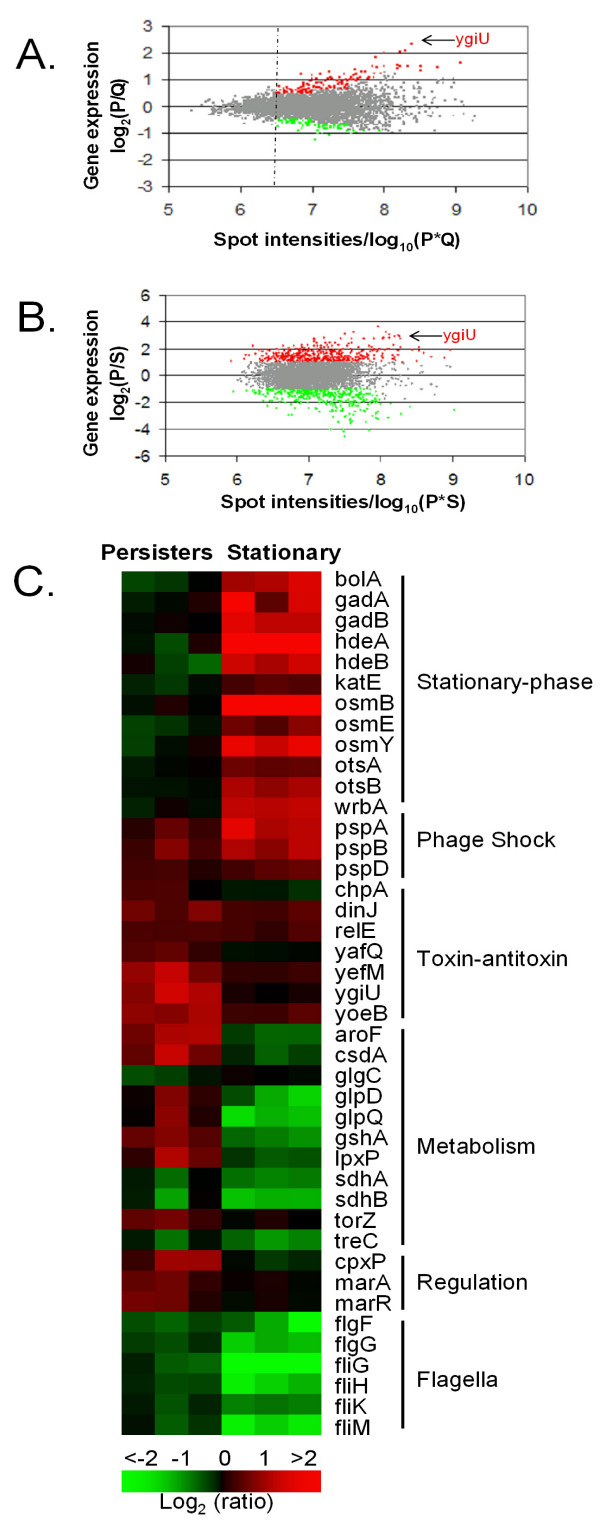
Gene expression profile of FACS isolated E. coli persisters. E. coli ASV Cells were sorted as described in legend, Fig. 2. cDNA was prepared from the total RNA and hybridized to spotted E. coli DNA microarrays [16]. Data shown are the averages of three independent biological replicates. Genes up-regulated in persisters are indicated as red and those genes which are repressed as green. The differential expressed genes are identified according to the procedures described in Materials and Methods. (A) Gene expression and spot intensities of sorted persisters (P) compared to sorted non-persisters (Q) from an exponential growth phase cell culture. (B) Gene expression and spot intensities of sorted persisters (P) compared to stationary phase (S) cells. (C) Heat map comparison of representative genes differentially expressed in persisters (P) or stationary (S) phase cells as compared to non-persisters (Q) and exponential growth phase cells (L), respectively. Genes are considered differentially expressed if the local intensity-dependent Z-score is greater than 1.96 or less than -1.96 and the expression log2 (ratio) is more than 1 or less than -1. The gene names are shown on the right, together with the functional groups.